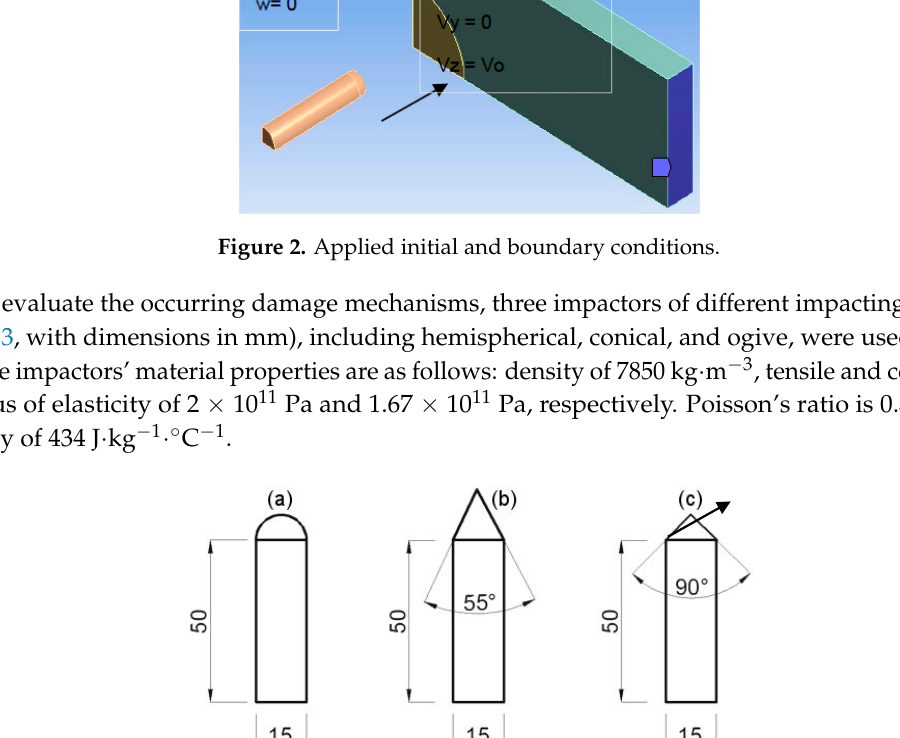
Figure 3. Geometry, shapes, and dimensions of impactors for ( a ) hemispheric, ( b ) conic 55°, ( c ) conic 90°, or Ogive.